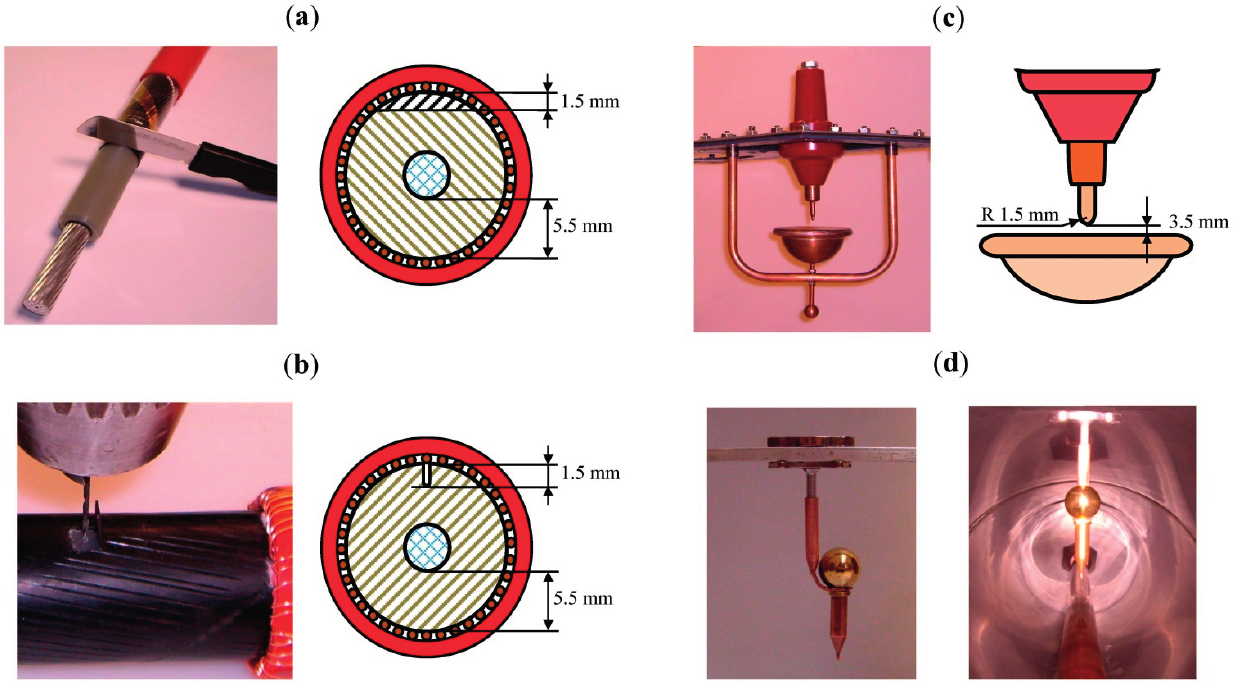
Figure 16. PD sources. ( a ) Transversal cut in the main insulation of a cable termination. ( b ) Internal void inside the main insulation of a cable; ( c ) Point-plane corona in air; ( d ) Corona in a GIS chamber.